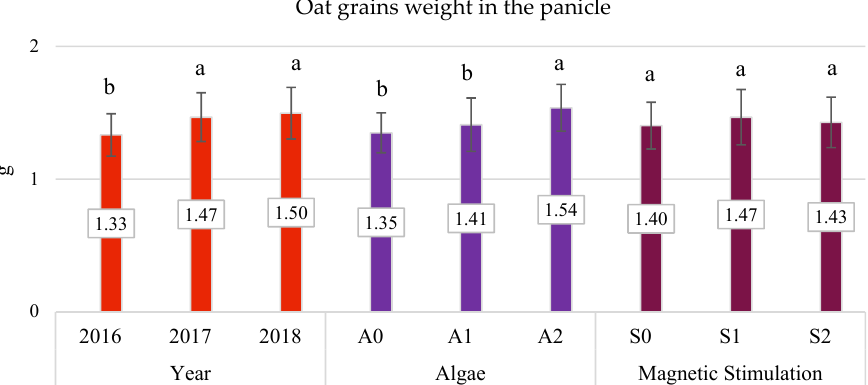
Figure 10. Effect of the alga dose and the MF exposure dose on oat grain weight in the panicle (in grams) from 2016 to 2018. According to Tukey’s HSD (honest significant difference) test, the means marked with the same letter were not significantly different at α ≤ 0.05.